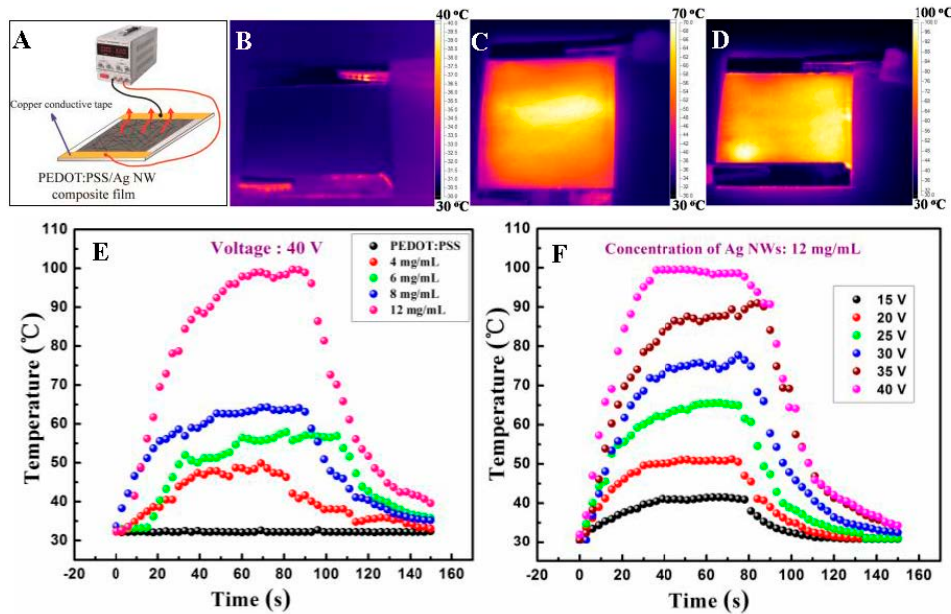
Figure 6. ( A ) Schematic illustration of a film heater based on the PEDOT:PSS/Ag NW composite film; infrared thermal images of the pristine ( B ) and composite film with NW concentration of 8 mg/mL ( C ); 12 mg/mL ( D ); the applied voltage was 40 V; ( E ) evolution of the generated temperature of the pristine and composite films with the different Ag NW concentrations ranging from 4 mg/mL to 12 mg/mL, the driving voltage was 40 V; and ( F ) evolution of the generated temperature of the composite film with the Ag NW concentration of 12 mg/mL at various voltages changing from 15 V to 40 V.